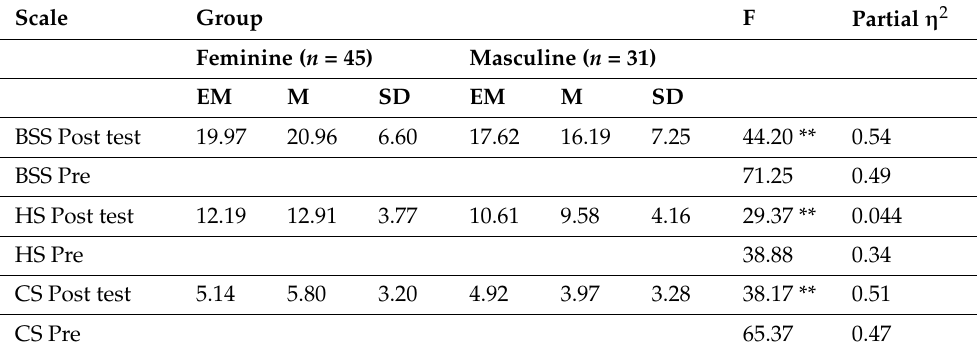
Table 4. The ANCOVA test for the results recorded on the 3 scales according to Gender. Scale